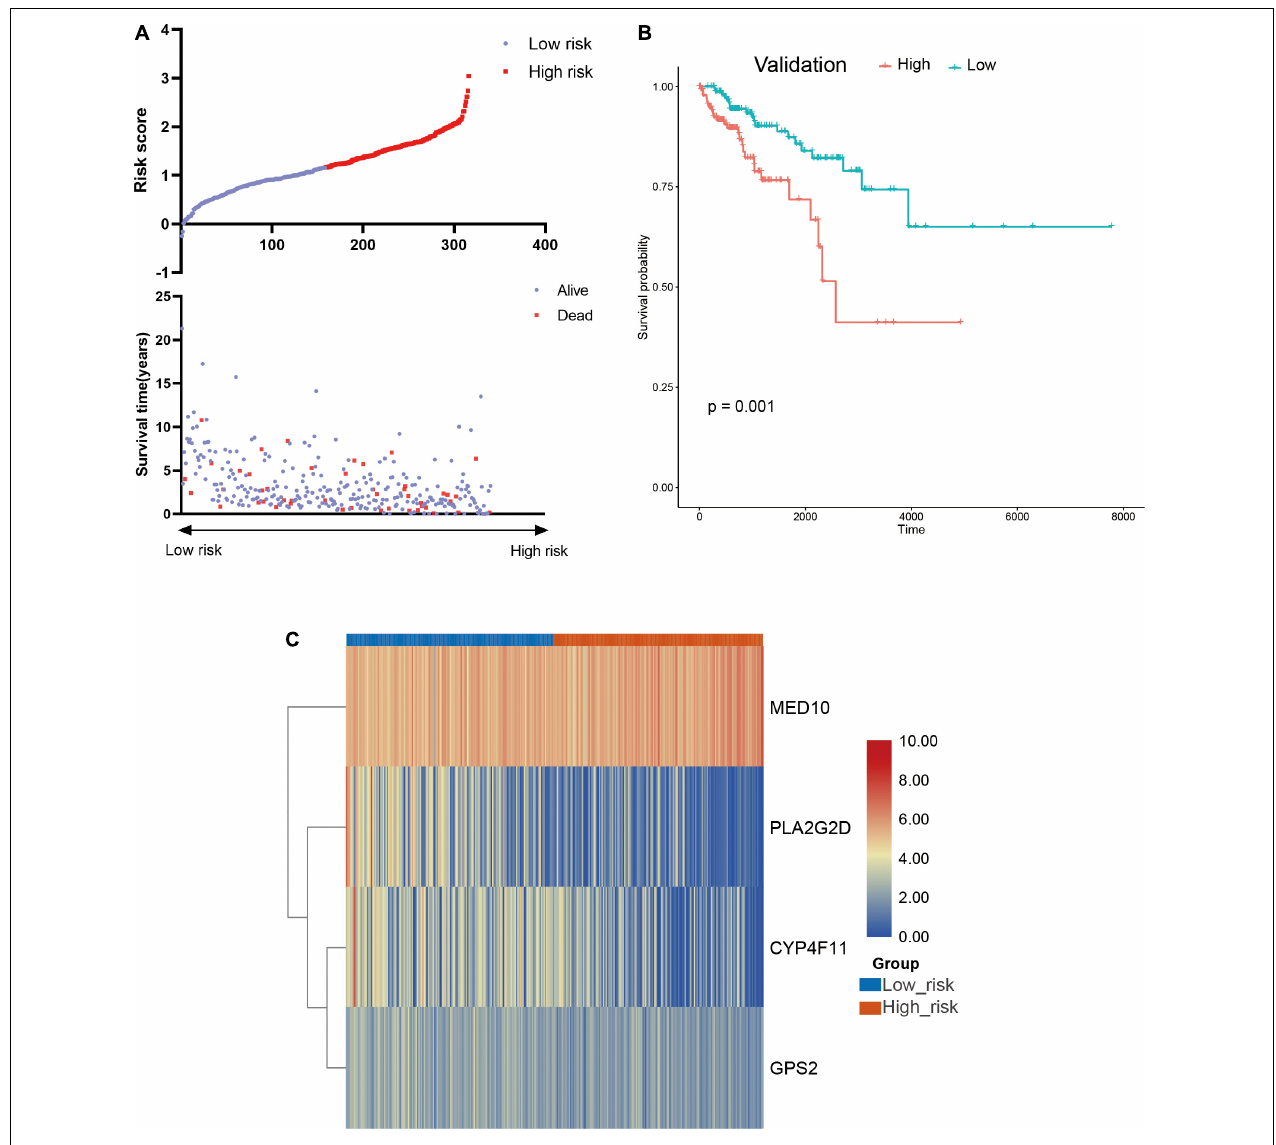
FIGURE 6 | Verification of the risk model in the validation cohort. (A) Survival status and risk score in the validation set, (B) survival curve showing the survival of the patients in the validation cohort, (C) heatmap illustrating the expression of candidate LMAGs in the validation